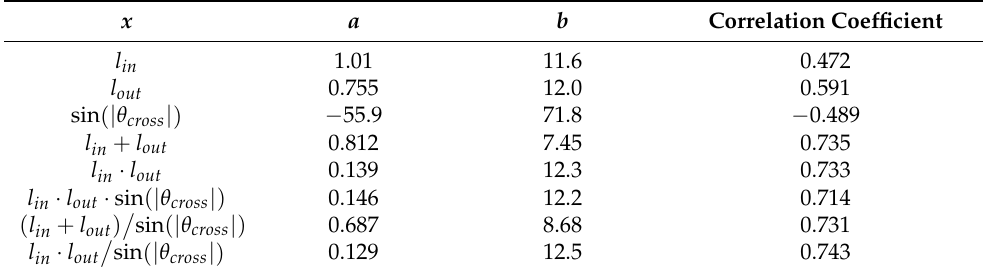
Table 2. Correlation equation between optimal distance parameter and intersection geometry re- lated parameter.